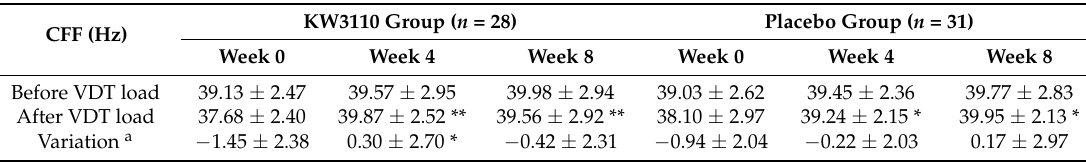
Table 3. Effects of L. paracasei KW3110 on CFF values.